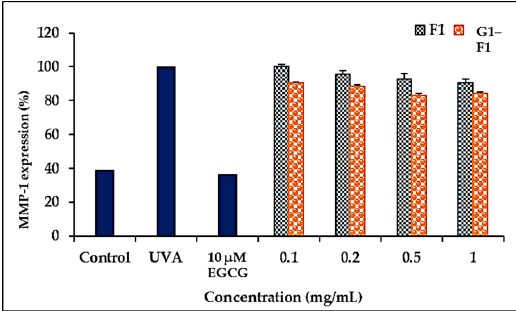
Figure5. Inhibitory effects of ginsenoside F1 and α‐ glycosylated ginsenoside F1 on the expression of MMP ‐ 1 in UVA ‐ irradiated human dermal fibroblasts. The cells were cultured in the presence